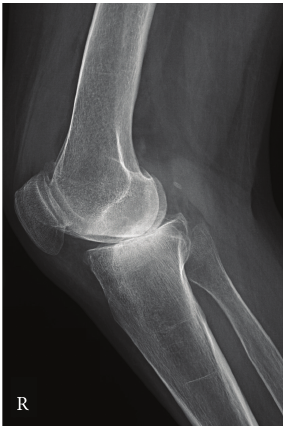
Figure 4: Lateral view of the right knee 22 months after